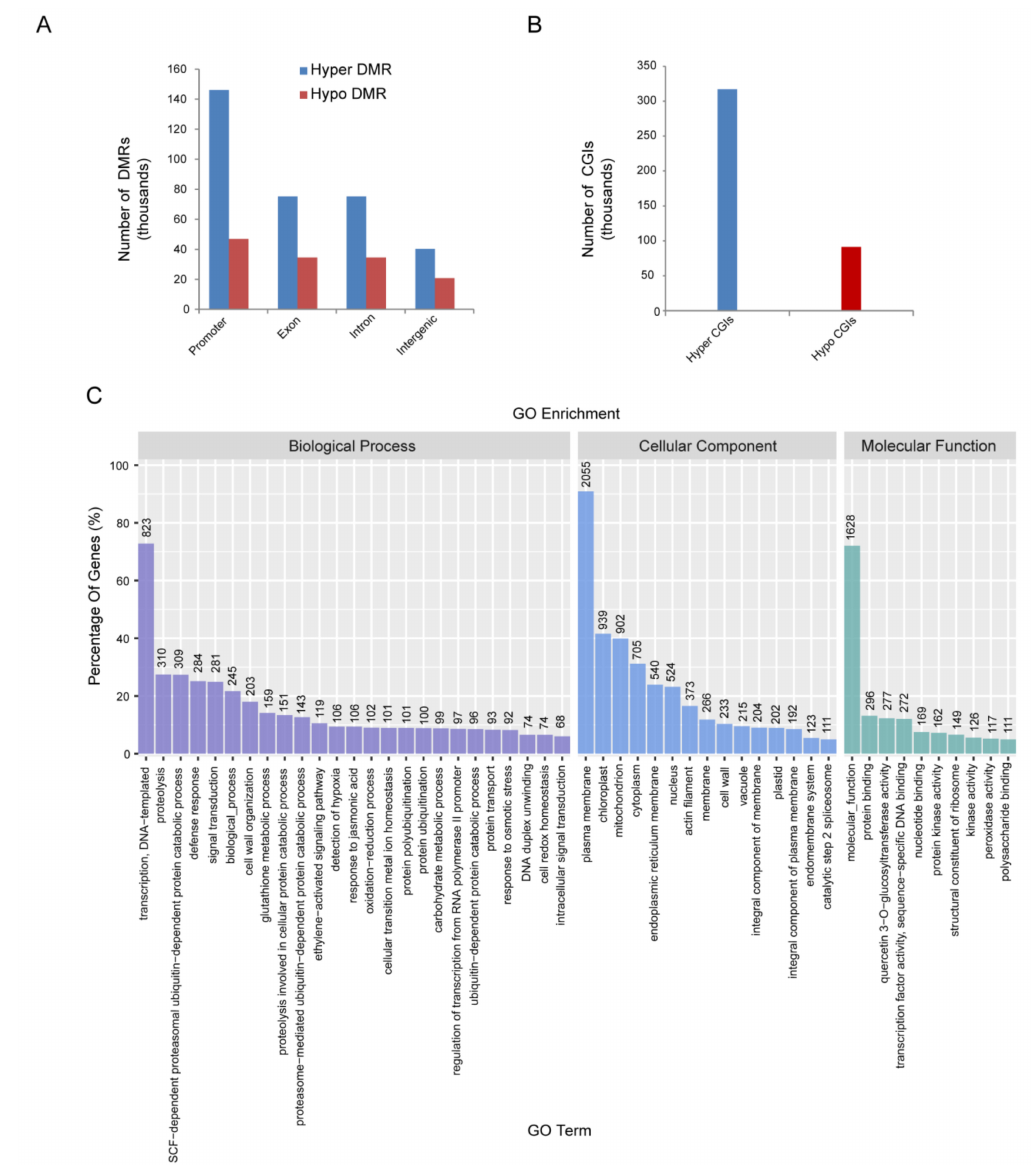
Figure 2. Characterization of DMR–associated genes. ( A , B ) Di ff erentially methylated regions (DMRs) number of gene body ( A ) and CGI ( B ) identified in rice infected by RBSDV. Promoter region is defined as − 1 kb to + 1 kb flanking transcription start site (TSS); gene body refers to + 1 kb downstream of TSS to transcription end site (TES), and the remainder is considered as intergenic region. ( C ) GO analysis of DMR-associated genes based on their functional